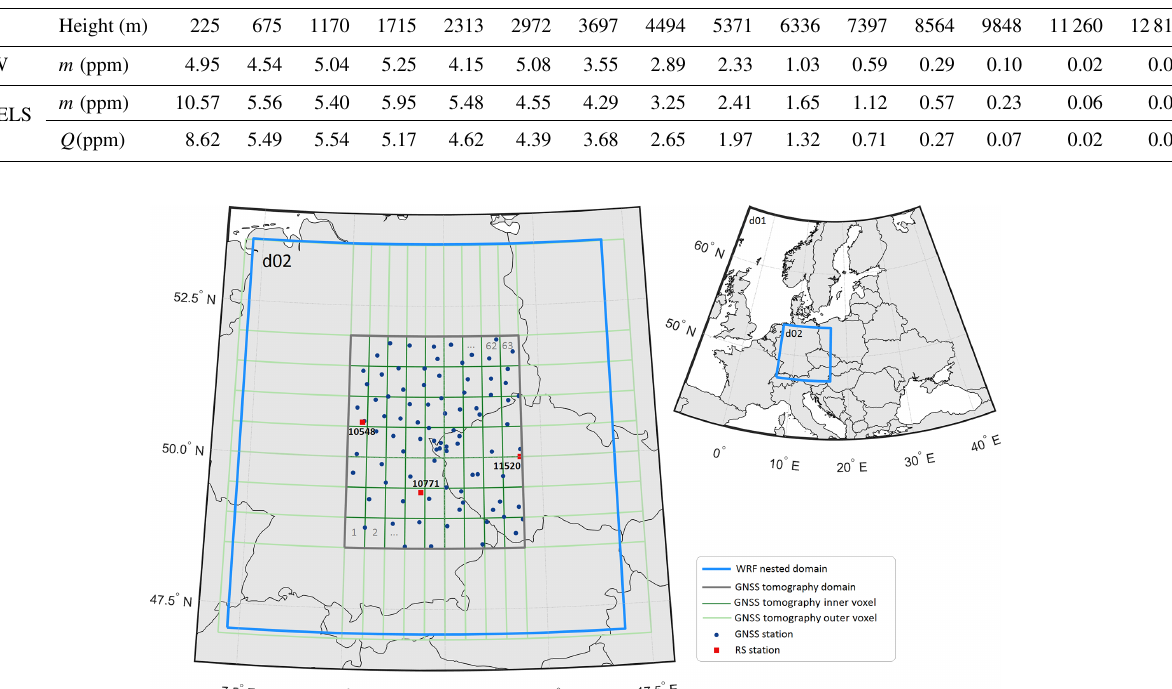
Figure 2. The geographical extensions of the WRF domains used in this research (d01 is coarse grid with 36km horizontal spacing; d02 is fine grid with 12km horizontal spacing), GNSS tomography domain (grey line), together with inner (dark green line) and outer (light green line) voxels, including GNSS sites (dark blue dots) and radiosonde stations (red